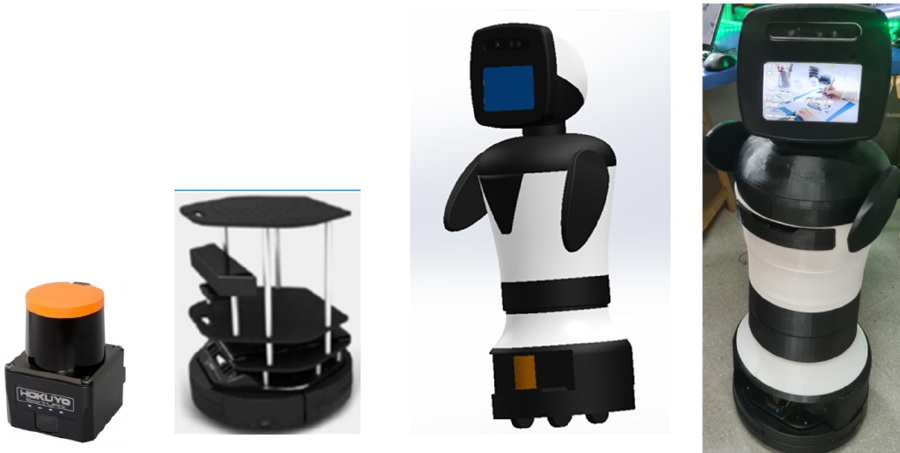
Figure 4. Assistive mobile robot: Turtlebot base and Hokuyo LIDAR ( left ), 3D model ( middle ) and real prototype ( right